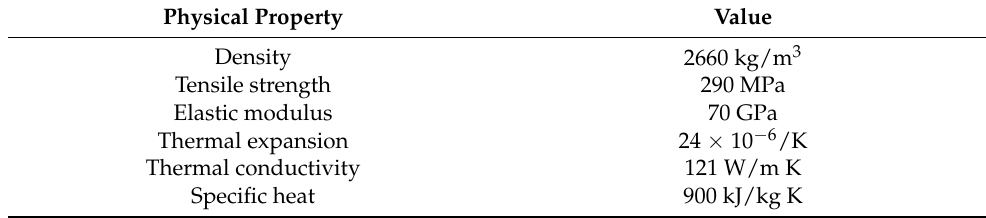
Table 1. Properties of aluminum 5083 at 25 ◦ C.